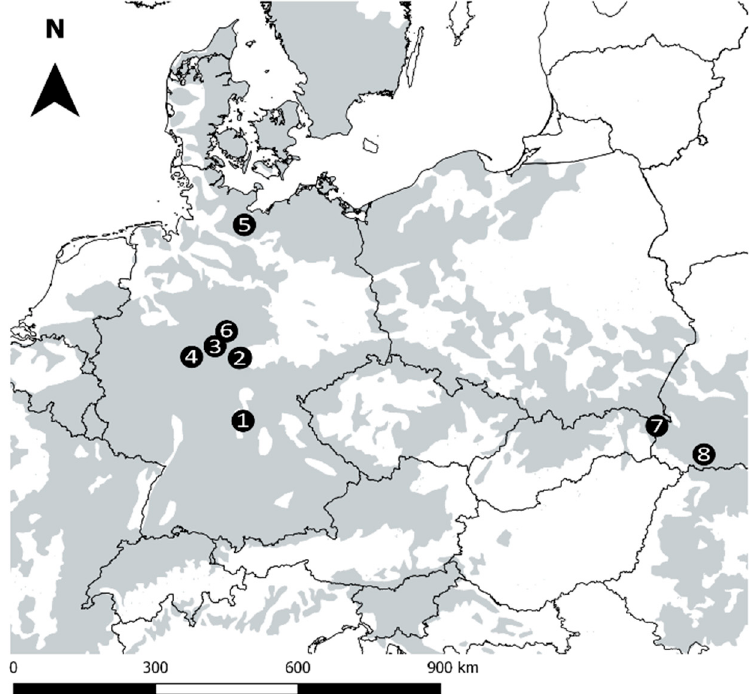
Figure 1. Natural distribution area of Fagus sylvatica L. in Central Europe (gray area) and location of the study sites. Each number represents one study site (1 = Ebrach, 2 = Hainich–Dün, 3 = Hann. Münden, 4 = Kellerwald, 5 = Lübeck, 6 = Reinhausen, 7 = Rožok and 8 = Uholka. Source of species distribution map: http://www.euforgen.org. (modified after Willim et al. [38]).